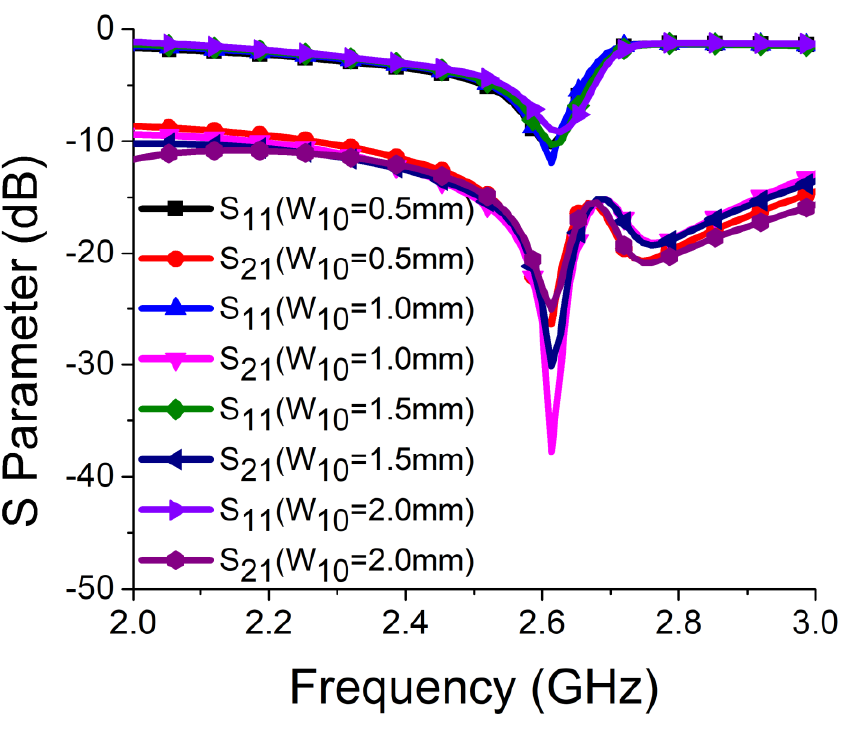
Figure 8. Effect of W 10 on resonance and isolation.